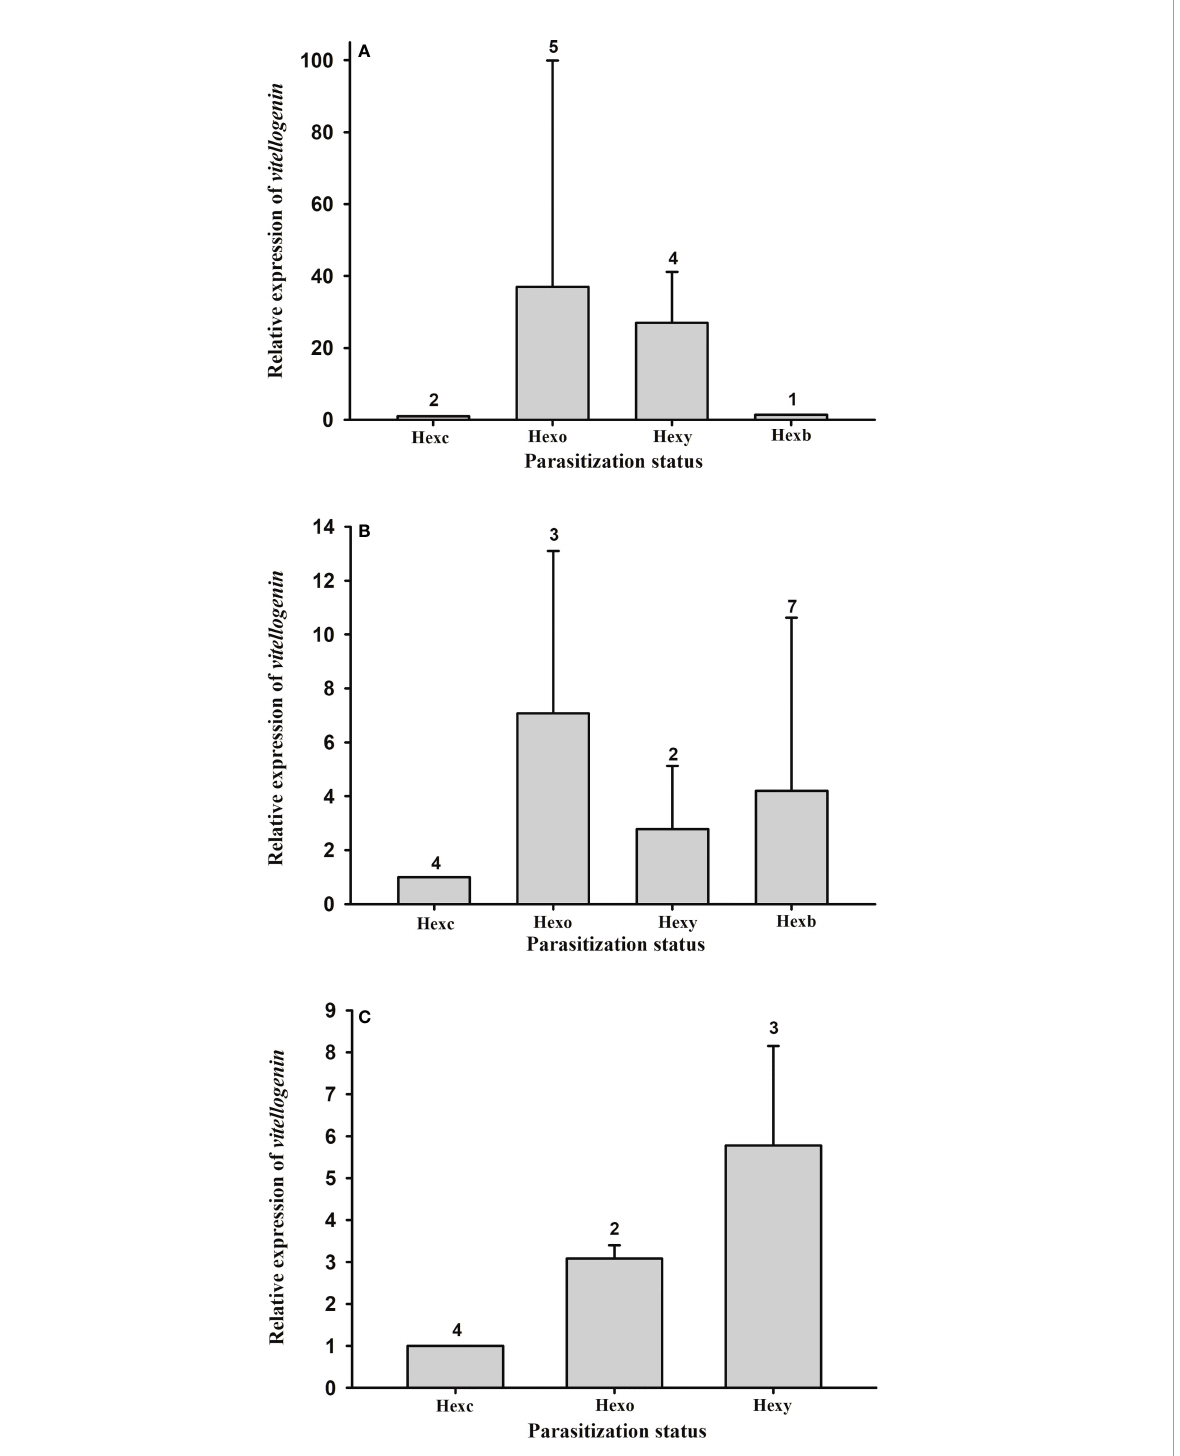
FIGURE 8 Expression pro fi le of vitellogenin gene in the thukuhar shore-crab ( Metopograpsus thukuhar ) parasitized by Polyascus planus . Total RNA prepared from the tissues was reverse transcribed and the cDNA ampli fi ed with primers as speci fi ed in the Materials and methods. Transcript levels in the tissue (A) : male hepatopancreas; (B) female hepatopancreas; (C) ; ovary taken from animals of various parasitization status were quanti fi ed by the real-time PCR, normalized to the reference gene (actin), and expressed relative to the levels of Hexc, the calibrator stage (Hexc = 1). Parasitization status: Hnp, non-parasitized hosts; Hexc, Hexo, Hexy, Hexb, hosts bearing creamy, orange, yellow, and brown externa, respectively. Number above the columns indicates the sample